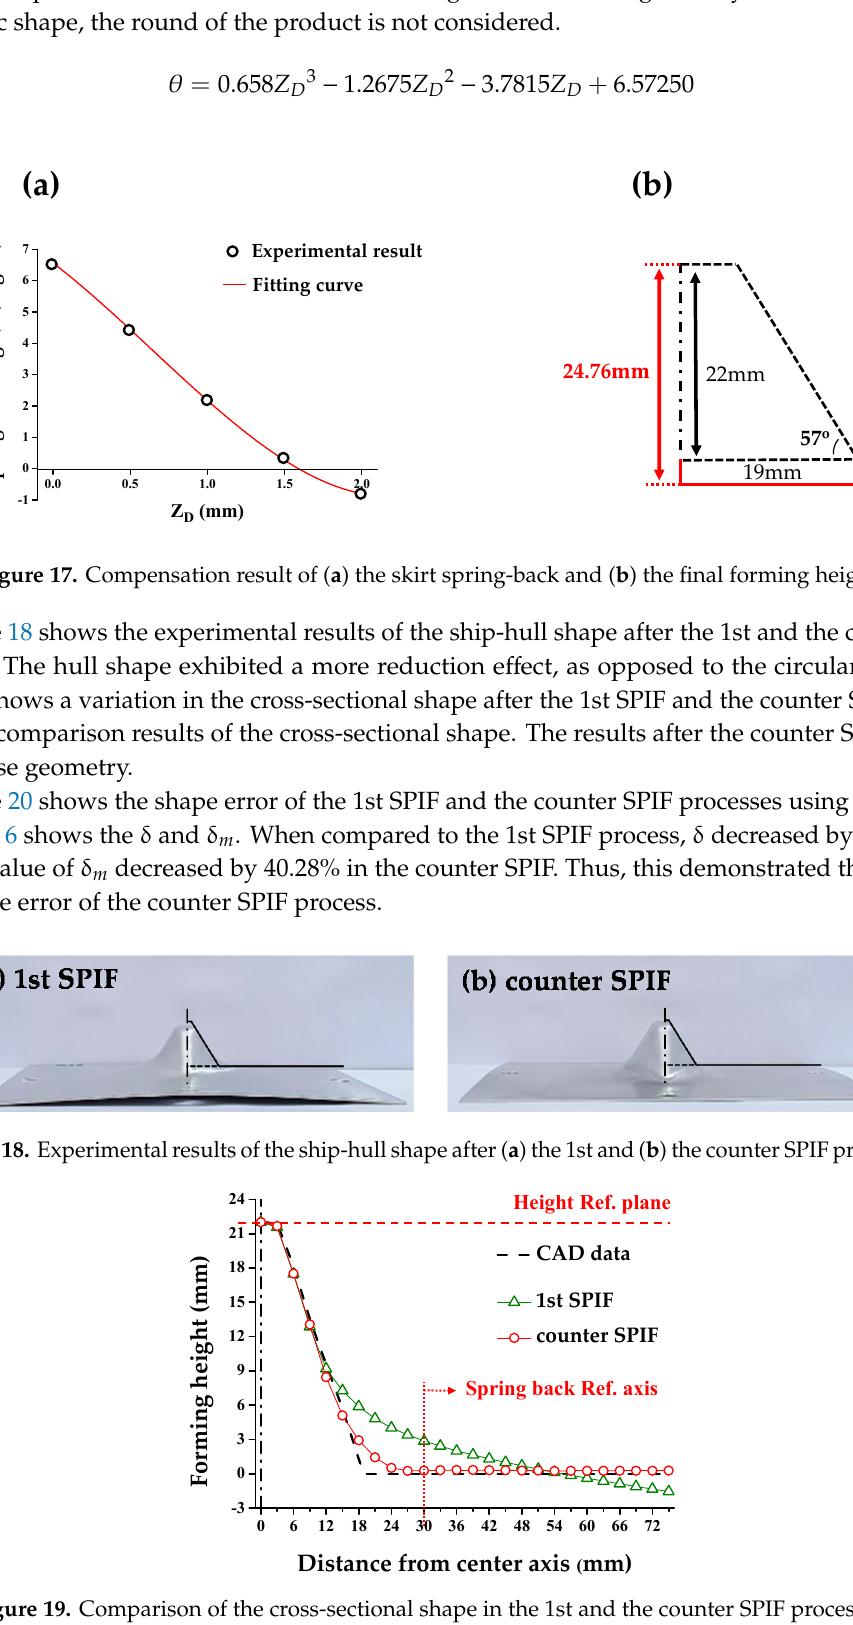
Figure 19. Comparison of the cross-sectional shape in the 1st and the counter SPIF processes.